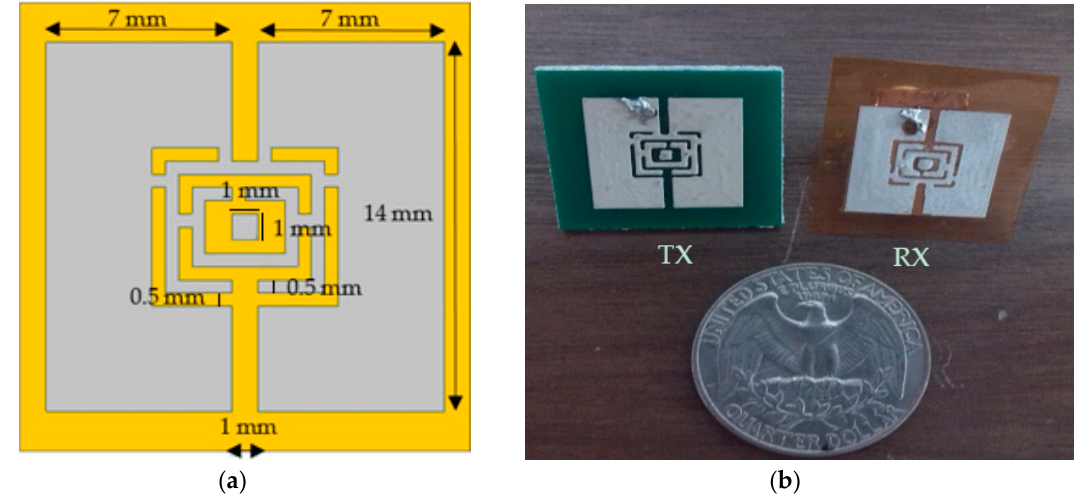
Figure 1. V-one from Voltera was used for fabrication.